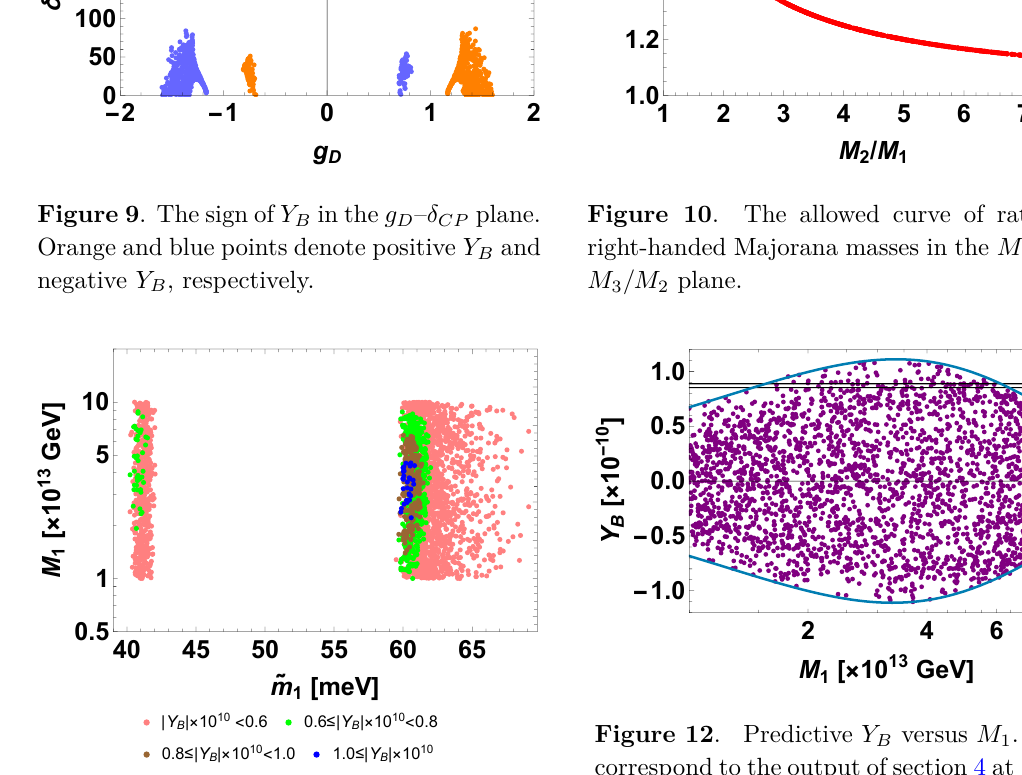
Figure 11 . Plot of ˜ m 1 and M 1 for each | Y B | .